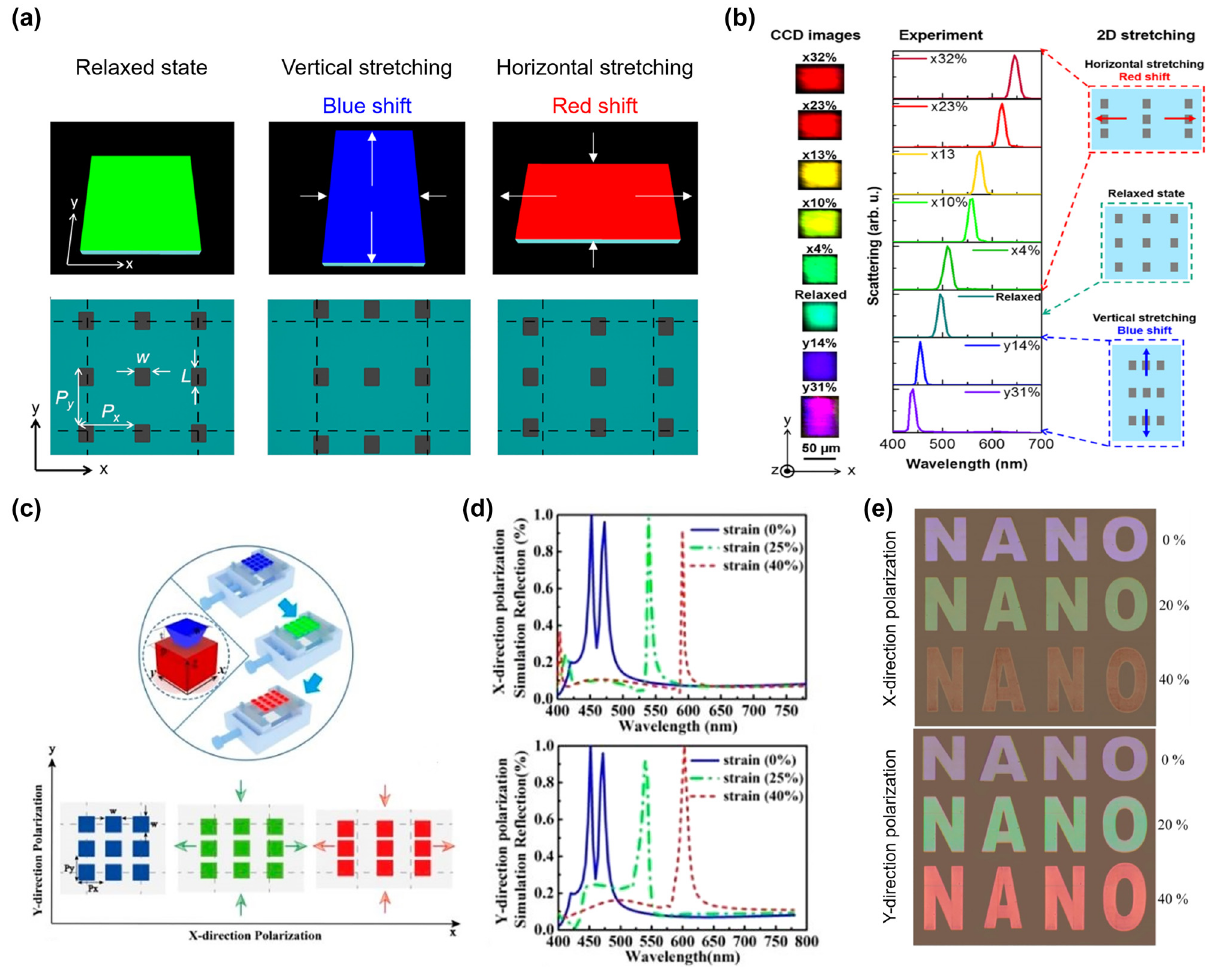
Figure 32: Dynamic structural color generation based on nanostructure geometric configuration modulation through mechanical stretching. (a) Working principle of the full-spectrum stretchable plasmonic color device, in which the top panel shows the schematic diagram of the device’s color change under different stretching conditions, and the bottom panel shows the corresponding schematic of the two-dimensional nanoparticle array. (b) Experimental results of the device performance under different stretching conditions, including the dark-field CCD images (left column) and the reflection spectra (middle column). The right column shows the schematic of the two-dimensional stretching method for full-color tuning. Modified metasurface and the colors of the with permission [323]. Copyright 2017, American Chemical Society. (c) Schematic illustration of the stretchable TiO 2 metasurface with 0% (solid line), 25% (dotted line), and 40% (dashed device under different strains along the x -axis. (d) Reflection spectra of the TiO 2 line) strains under x - and y -polarized illuminations. (e) Optical images of a fabricated sample at different stretching conditions under x - and y -polarized illuminations. Modified with permission [324]. Copyright 2019, American Chemical